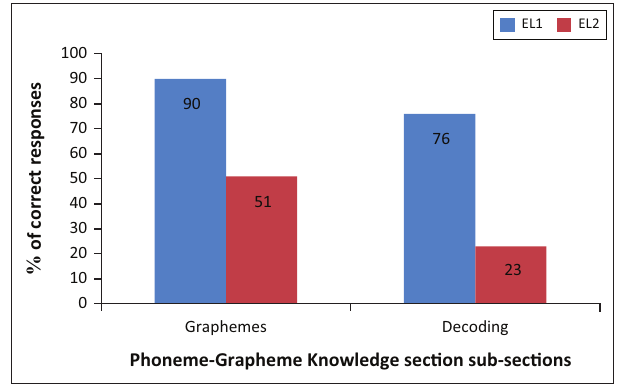
FIGURE 3: Sub-sections of the Phoneme-grapheme Knowledge section of the PAT-2 : The percentage of correct responses of English first language and English second language learners.